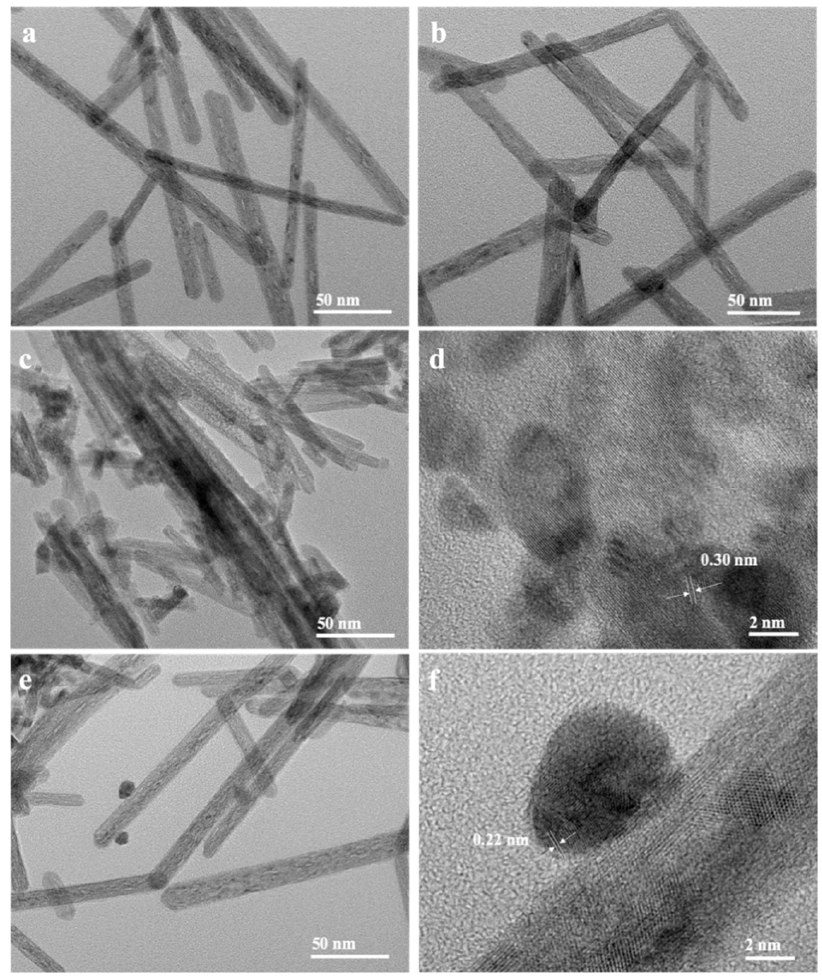
Figure 4. TEM and HRTEM images of ( a ) 0.3% PdO/CeO 2 -RE, ( b ) 0.5% PdO/CeO 2 -RE, ( c , d ) 1% PdO/CeO 2 -RE and ( e , f ) 0.5% PdO/CeO 2 -IM.